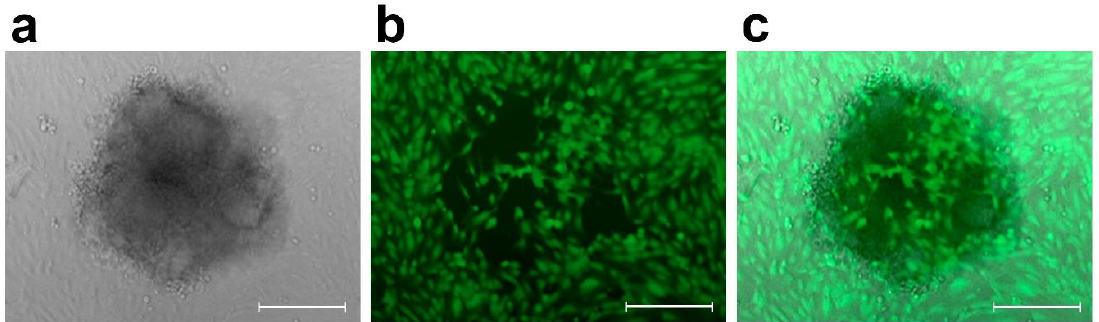
Figure 4. CCID assay set-up. ( a ) A SW620 cell spheroid (phase contrast microscopy) placed on top of ( b ) a monolayer of LECs stained with cytotracker (green; fluorescence microscopy using a FITC filter). After 4 h co-cultivation, the developed CCID in the LEC-monolayer due to 12(S)-HETE secreted by the spheroid, which causes the retraction of LECs, was photographed with 200-fold magnification. ( c ) Merge of phase contrast and fluorescence micrography. Scale bars: 200 µ